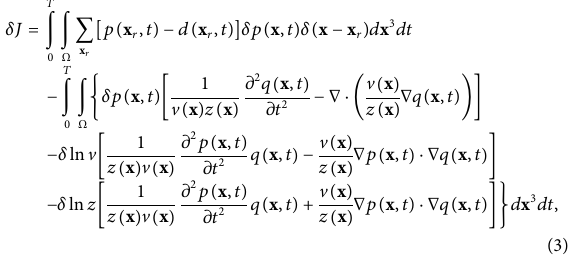
FIGURE 1 Geometry of incident and scattering waves. Red lines are the wave paths of the forward and adjoint wave fi elds. k and k † denote their propagation directions. ( x , z ) is the Cartesian coordinate system and θ is the scattering